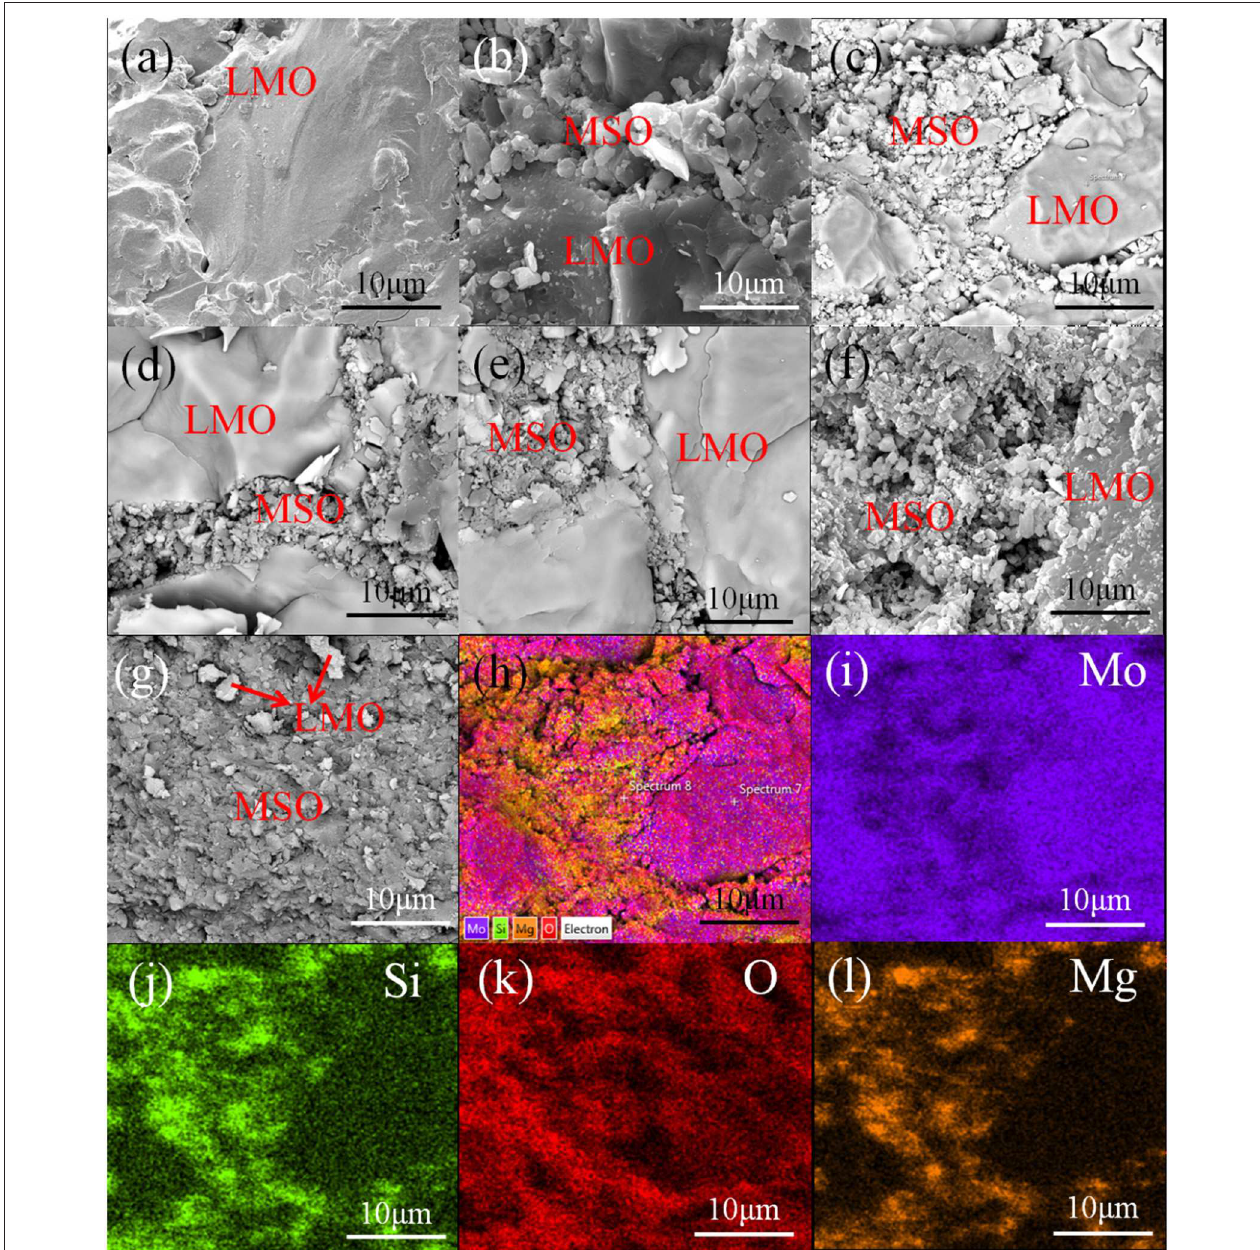
FIGURE 2 | SEM images of cold-sintered (a) LMO; (b) 95 wt% LMO − 5 wt% MSO; (c) 90 wt% LMO − 10 wt% MSO; (d) 80 wt% LMO − 20 wt% MSO; (e) 70 wt% LMO − 30 wt% MSO; (f) 50 wt% LMO − 50 wt% MSO and (g) 10 wt% LMO − 90 wt% MSO composite ceramics; EDS element mapping of LMO-MSO: (h) element layered image; (i) Mo; (j) Si; (k) O and (l) Mg.